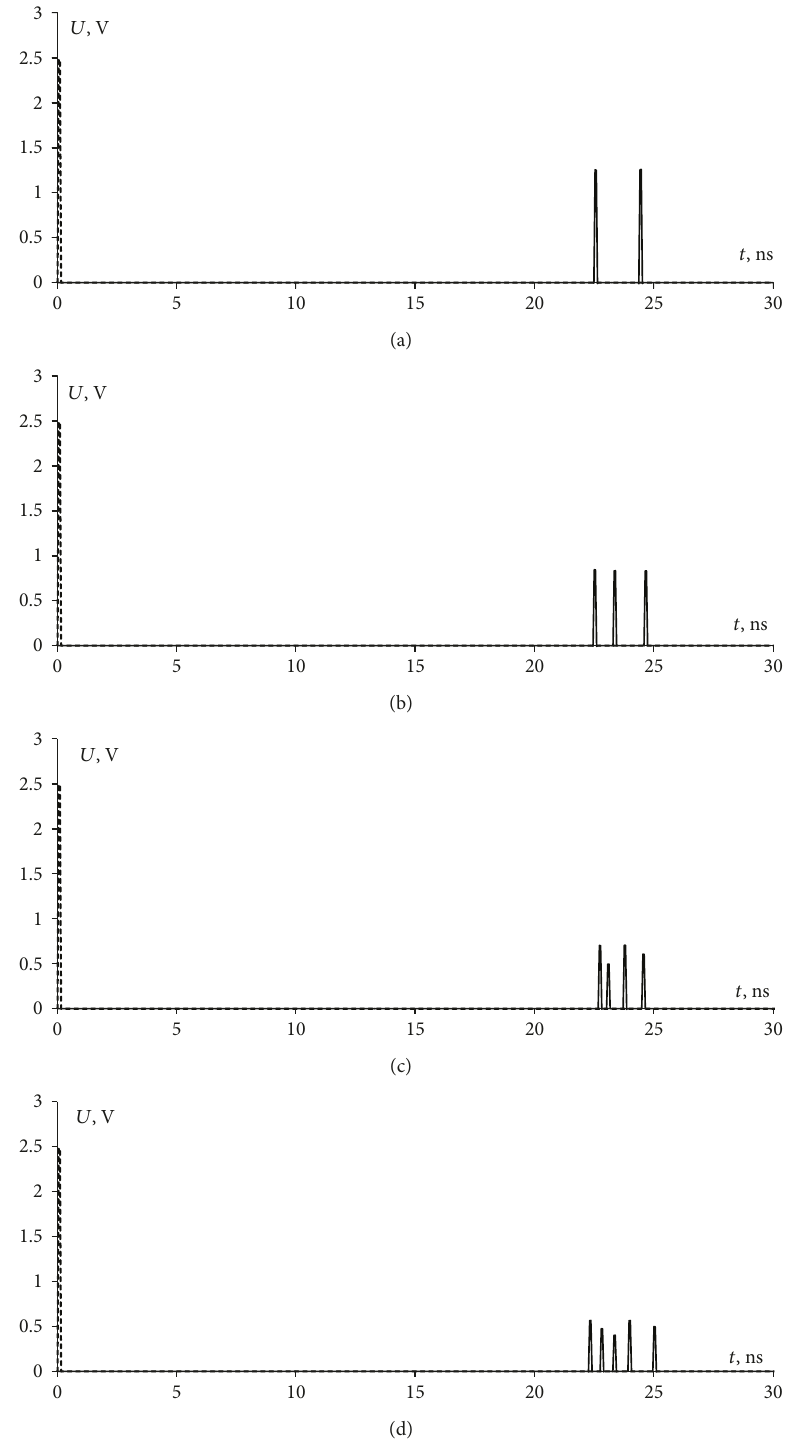
Figure 4: Voltage waveforms at the input ( – · – ) and the output ( — ) of conductor 1 for two- (a), three- (b), four- (c), and fi ve- (d) conductor MFs with parameters, obtained by heuristic search